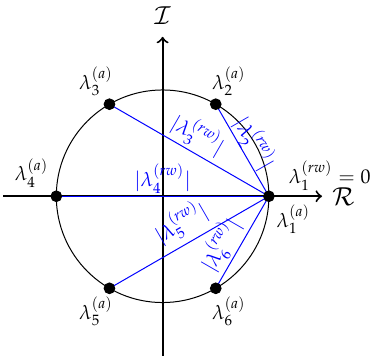
( a ) ∀ m } and modulus of the eigenvalues of L ( rw ) given by m ;